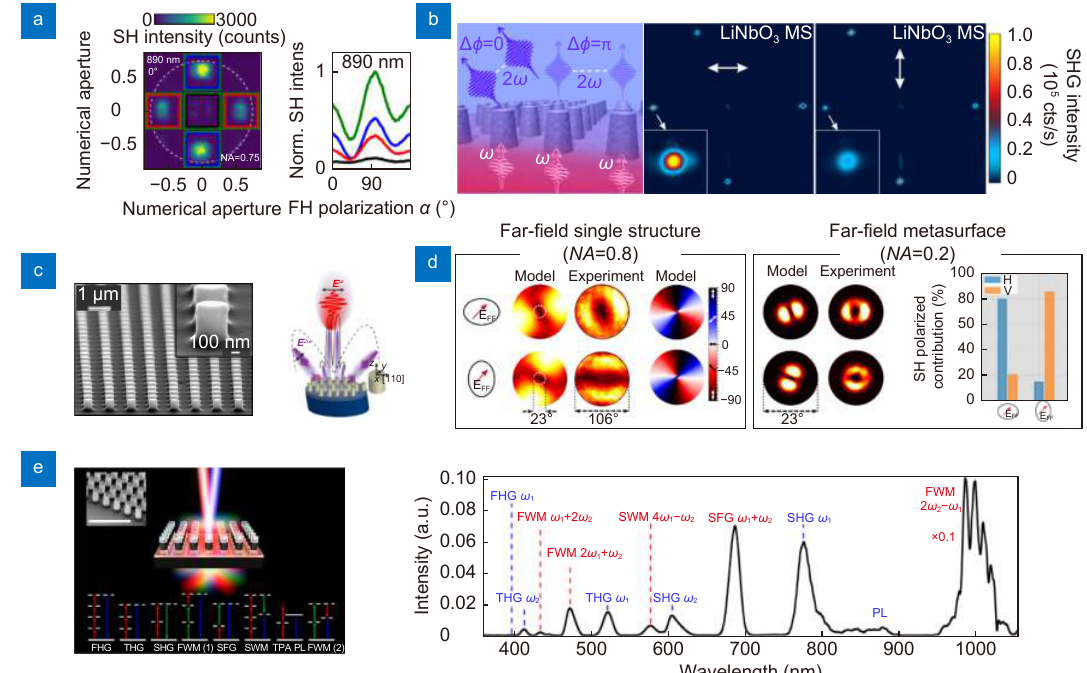
Fig. 3 | Arrays of quasi-independent dielectric χ (2) Mie-type resonators. ( a ) SHG from a GaAs metasurface radiated into different diffraction orders vs. pump polarization angle. Green: total; blue: (0,±1) orders; red: (±1,0) orders; black: (0,0) order 98 . ( b ) SH back-focal plane (BFP) ima- ging of a LiNbO 3 metasurface for horizontally (center) or vertically (right) polarized pump 101 . ( c ) Mechanism to partially redirect SHG from an Al- GaAs metasurface close to normal direction 99 . ( d ) Controlling SH polarization. BFP imaging of SH from isolated (left) or arrayed (right) AlGaAs nanoantennas with elliptical basis 100 . ( e ) Broadband frequency generation in a GaAs metasurface through multiple nonlinear processes 96